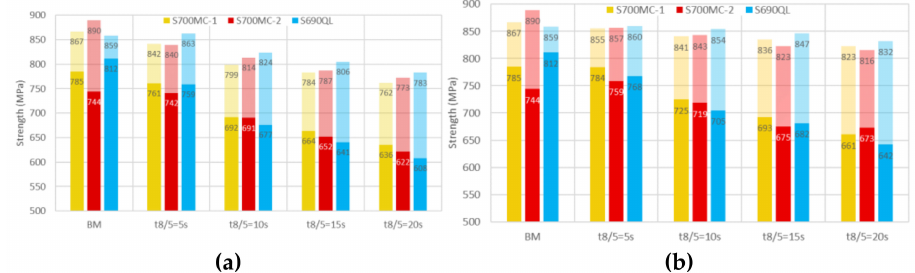
Figure 6. Yield and ultimate tensile strength of the welds: ( a ) machined specimens; ( b ) specimens with